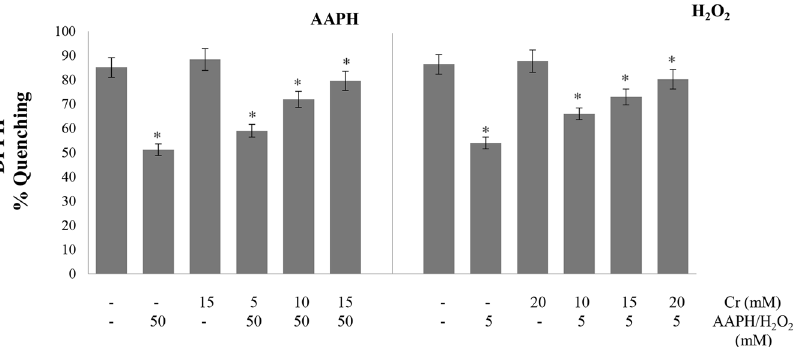
Fig 6. Effect of creatine on AAPH/ H 2 O 2 -induced changes in DPPH radical scavenging activity. Erythrocytes were treated with the indicated concentrations of H 2 O 2 /AAPH, in presence and absence of Cr. DPPH assay was done in hemolysates. Results are mean values ± SEM from six independent experiments using blood from different donors. * Significantly different from control ( p <